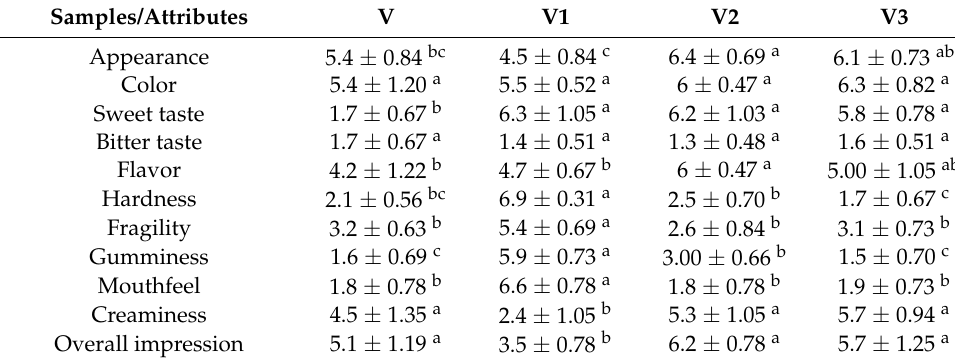
Table 7. Sensorial analysis of jellified products.